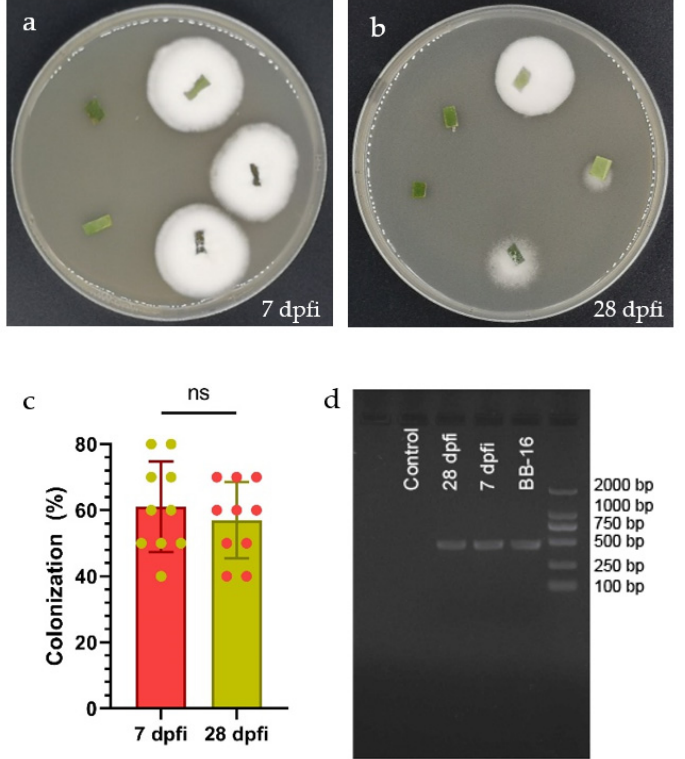
Figure 1. ( a , b ) Beauveria bassiana re-isolated from leaves at 7 and 28 dpfi, respectively. ( c ) Mean (+SE) percent colonization of Citrus sinensis leaves by Beauveria bassiana BB-16 at 7 and 28 dpfi; data were analyzed using t -test at p < 0.0001. ( d ) Detection of Beauveria bassiana BB-16 in newly emerged leaves from inoculated plants sampled at 7 and 28 dpfi using PCR assay.